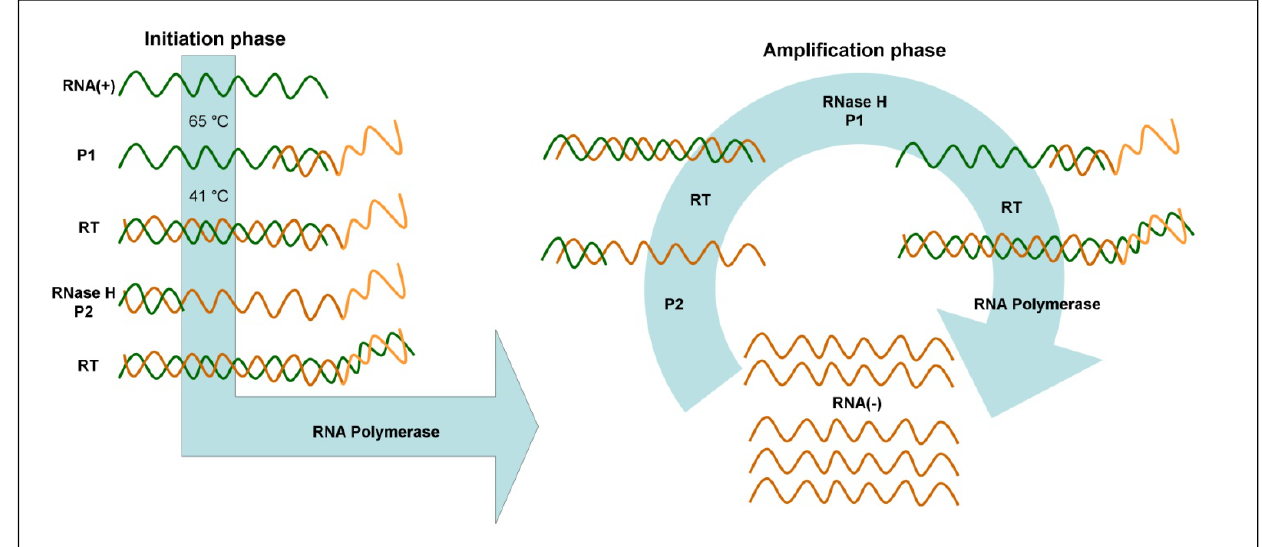
Figure 4. Schematic representation of nucleic acid sequence-based amplification